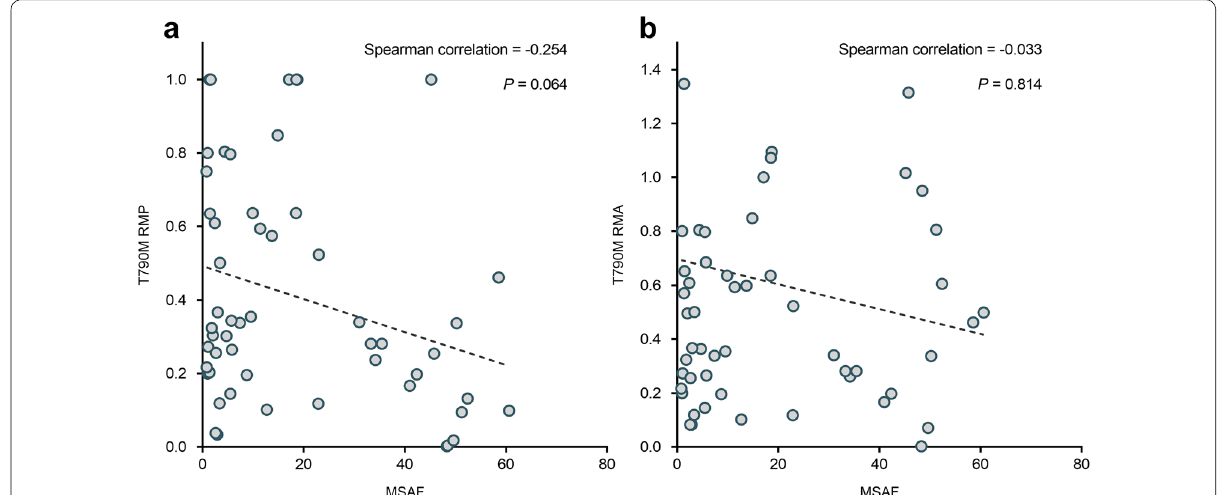
Fig. 3 Maximum somatic allele frequency (MSAF) was not correlated with T790M relative mutation purity (RMP) and T790M relative mutation abundance (RMA). a Correlation between MSAF and T790M RMP in the 54 patients (Spearman correlation between MSAF and T790M RMA in the 54 patients (Spearman correlation